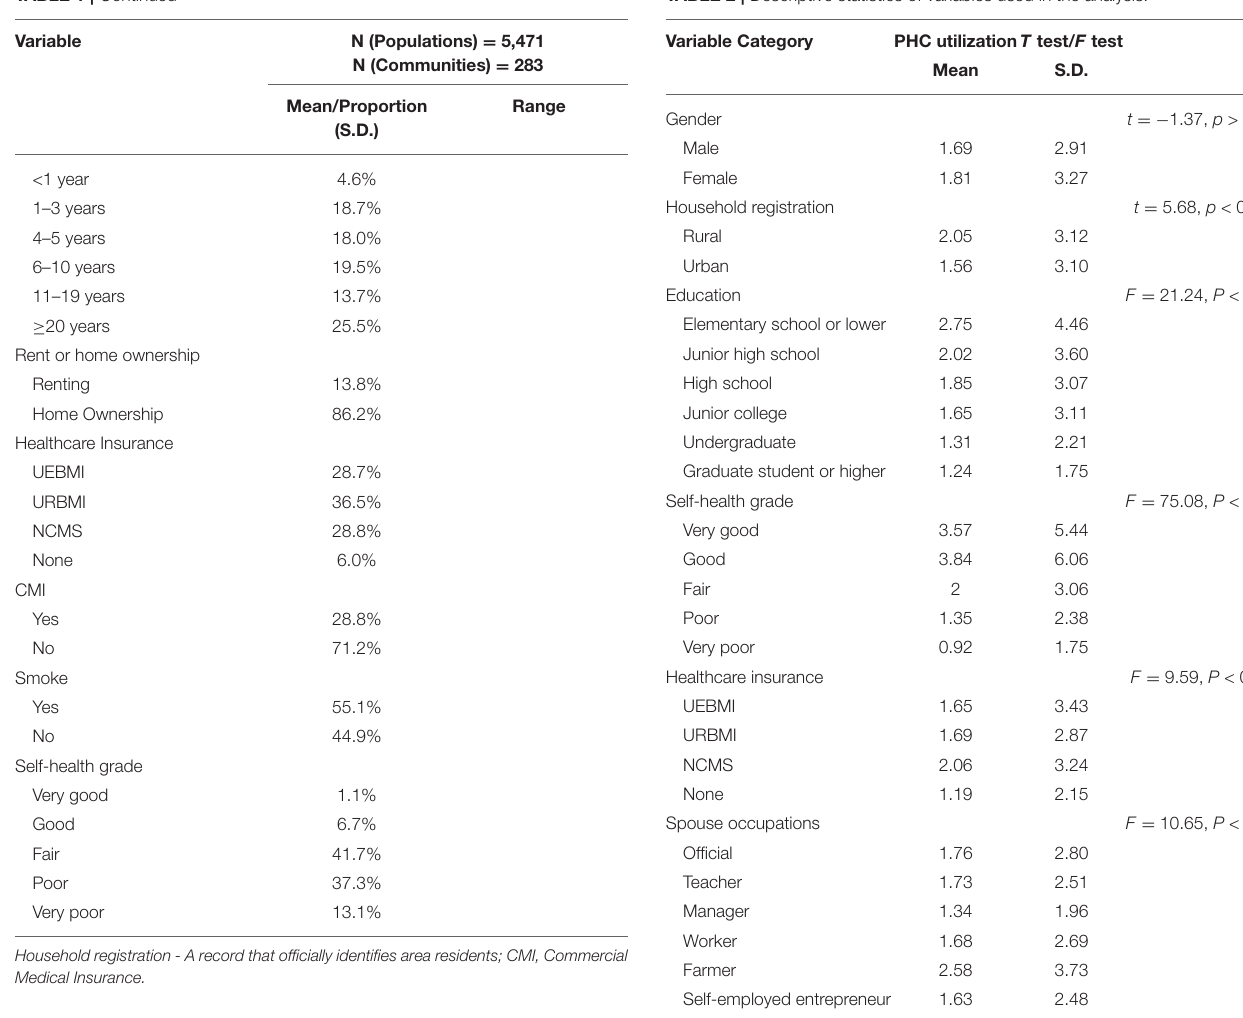
TABLE 2 | Descriptive statistics of variables used in the